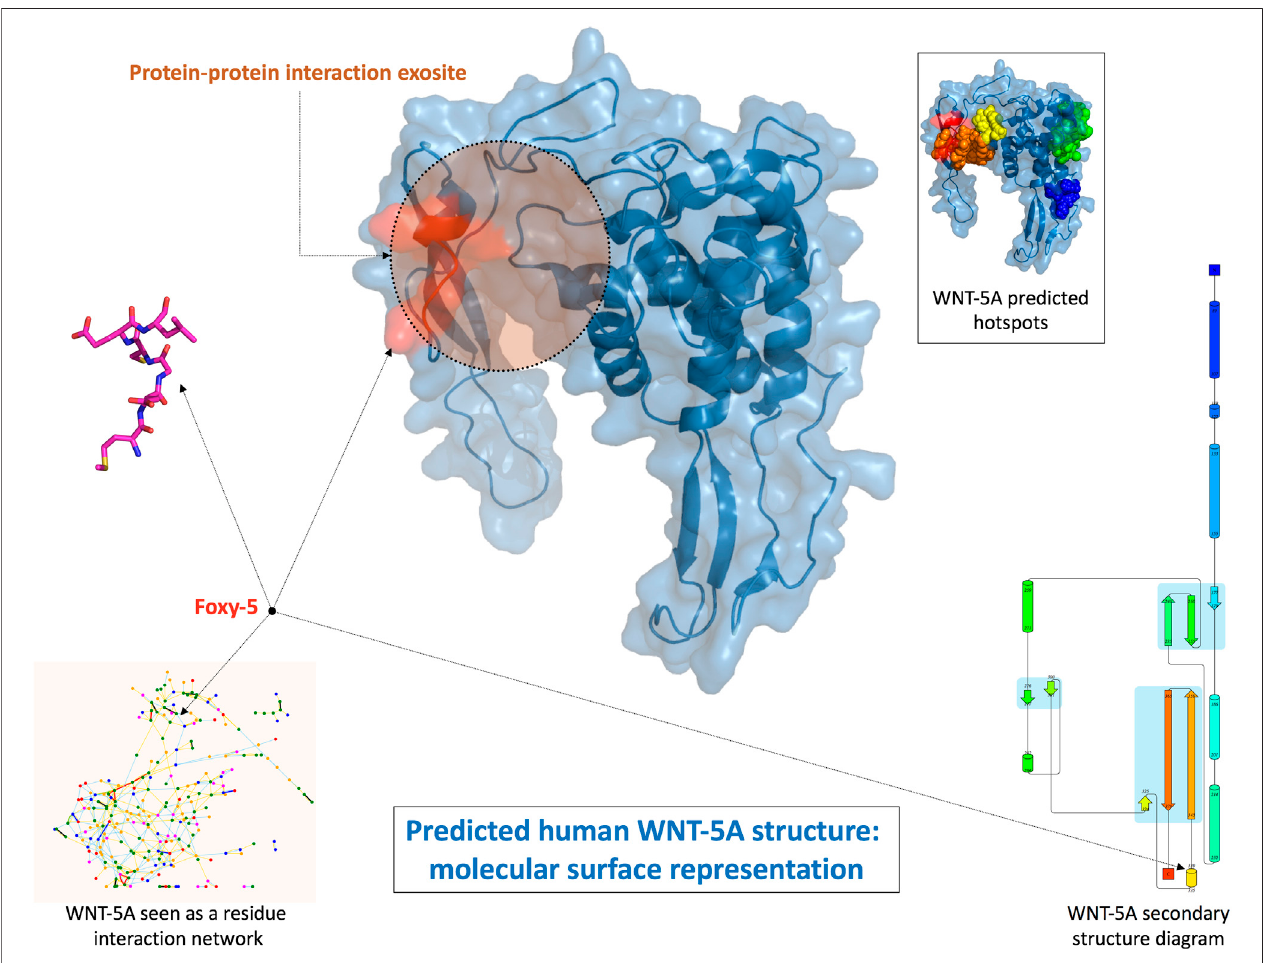
FIGURE 4 | Structural prediction of human WNT-5A and Foxy-5 conformation (Villoutreix,